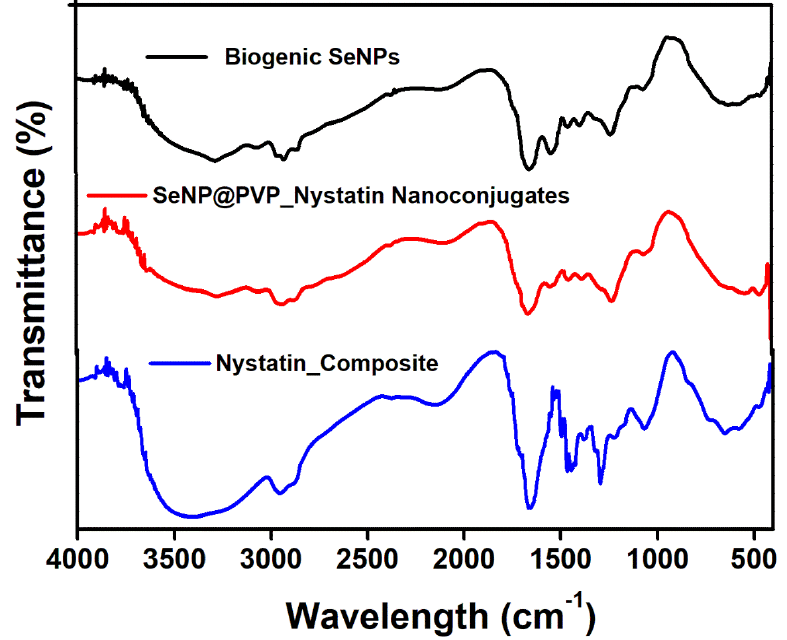
Figure 3. FTIR analysis of Biogenic SeNPs, Nystatin composite, and SeNP@PVP_Nystatin nanoconjugates.